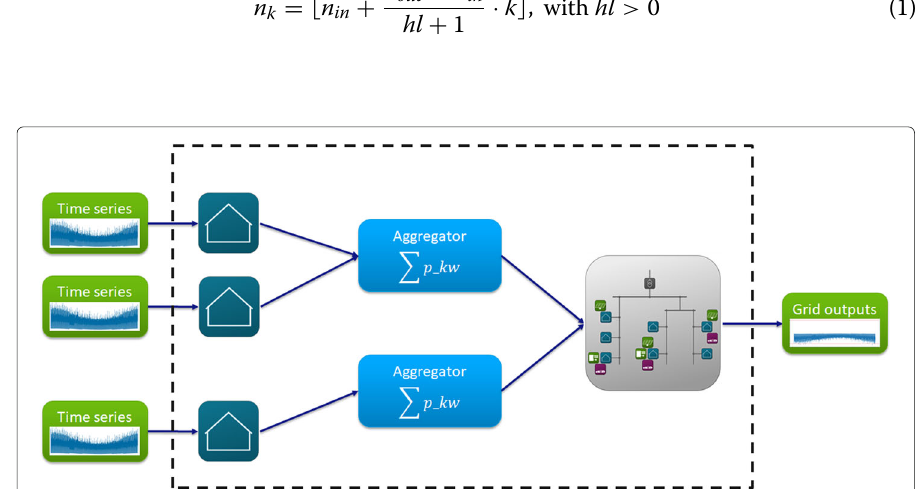
Fig. 5 The simulation setup. The time series are connected to simple household models, which are connected via aggregator models to the power grid. All the communication is handled by mosaik. Everything in the dashed box is to be replaced by a surrogate